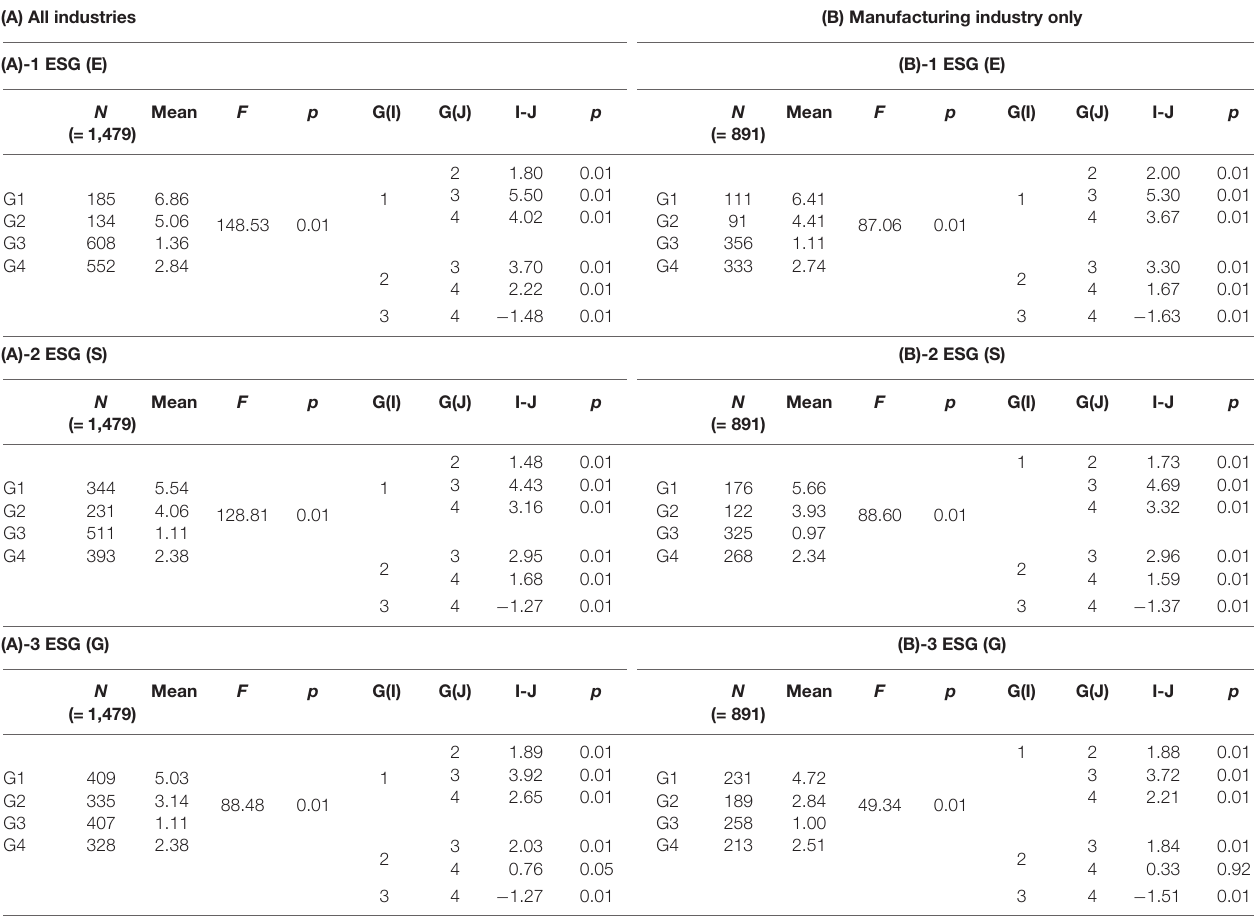
TABLE 9 | ANOVA and post hoc analysis for ESG and financial